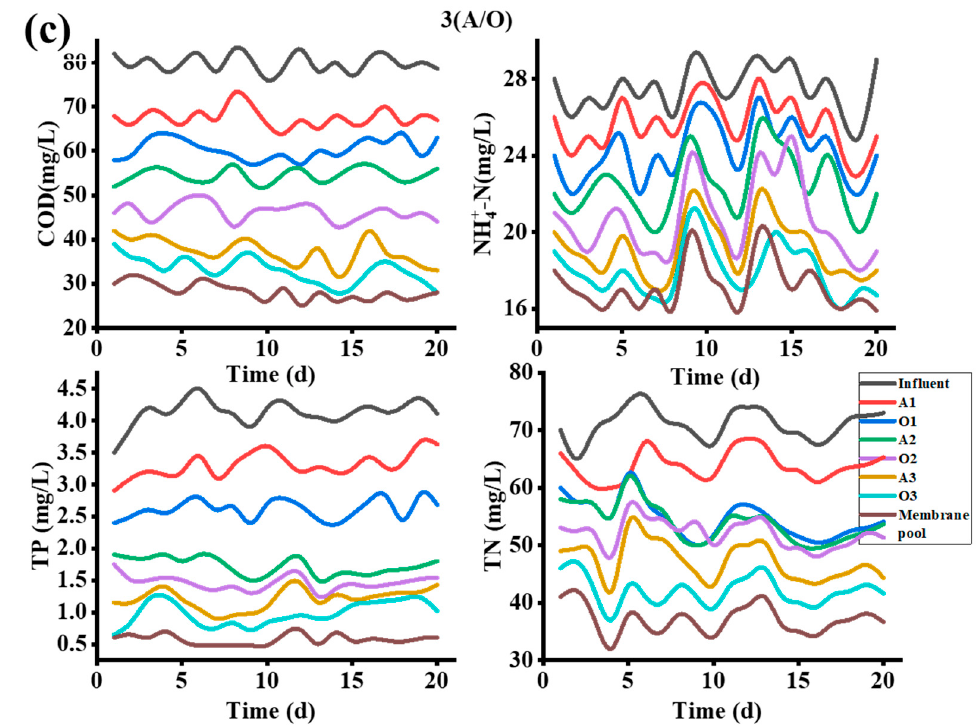
Figure 3. Treatment effect of overflow O-MAO-MBR on sewage ( a ) A/O-MBR change, ( b ) 2(A/O)- MBR changes, and ( c ) 3(A/O)-MBR changes.